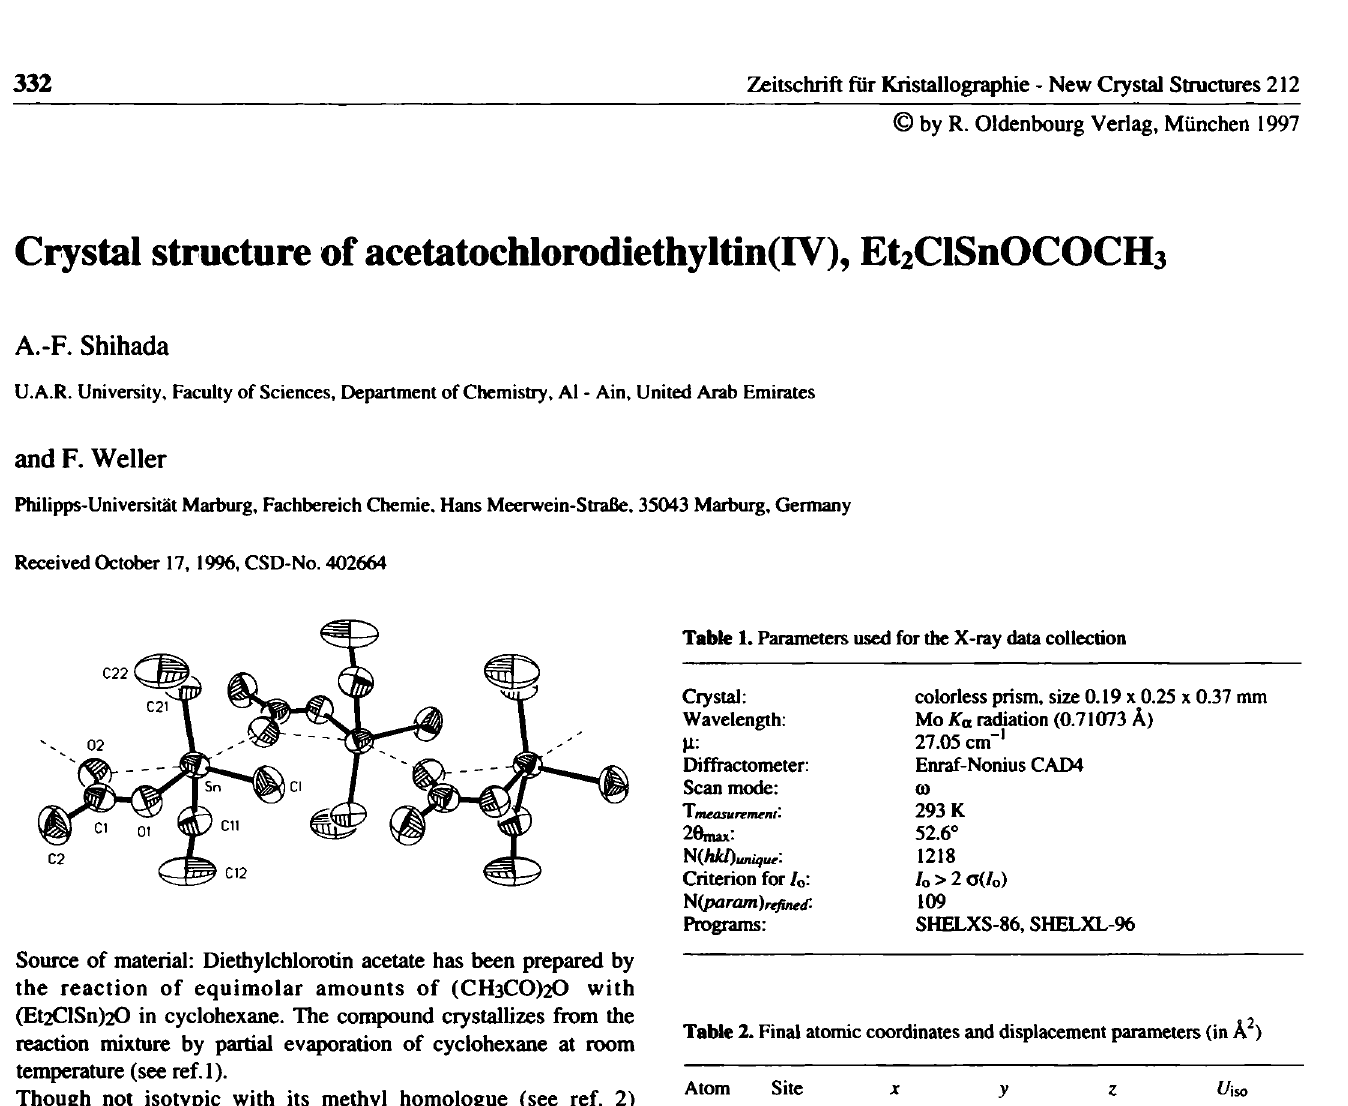
Table 3. Final atomic coordinates and displacement parameters (in Â 2 )